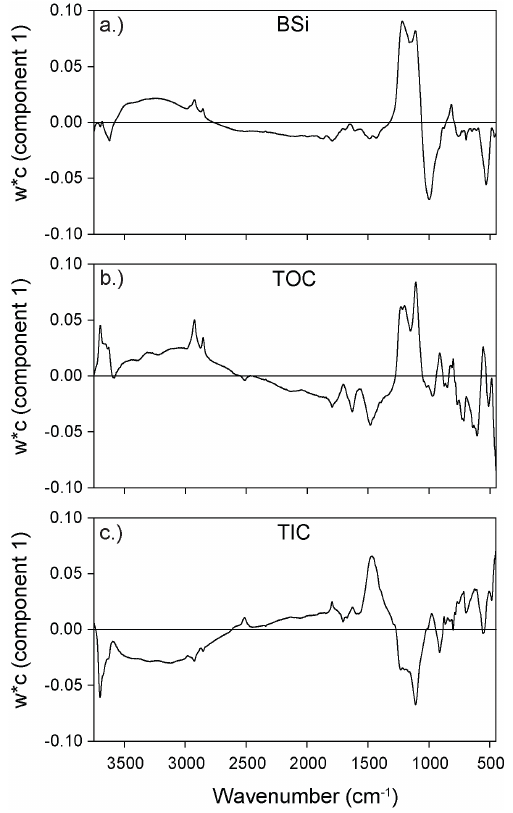
Fig. 3. Loadings of the developed FTIRS-calibration models for (a) biogenic silica (BSi), (b) total organic carbon (TOC), and (c) total inorganic carbon (TIC) showing the contribution of each wavenumber to the partial least squares (PLS) regression model. Positive values indicate wavenumbers positively correlated with the property of interest and negative values indicate wavenumbers neg- atively correlated with the property of interest. Loadings are ex- pressed by weight vectors ( w × c ) of the first PLS model compo- nent ( x axis) and the corresponding spectral range ( y axis). The calibration models are based on sediment samples from percussion piston cores PG1351 ( n =83 for BSi, n =156 for TOC) and Lz1024 ( n =204 for BSi) and samples distributed throughout the entire drill core composite profile of ICDP site 5011-1 ( n =133 for BSi, n =153 for TOC, n =152 for TIC).